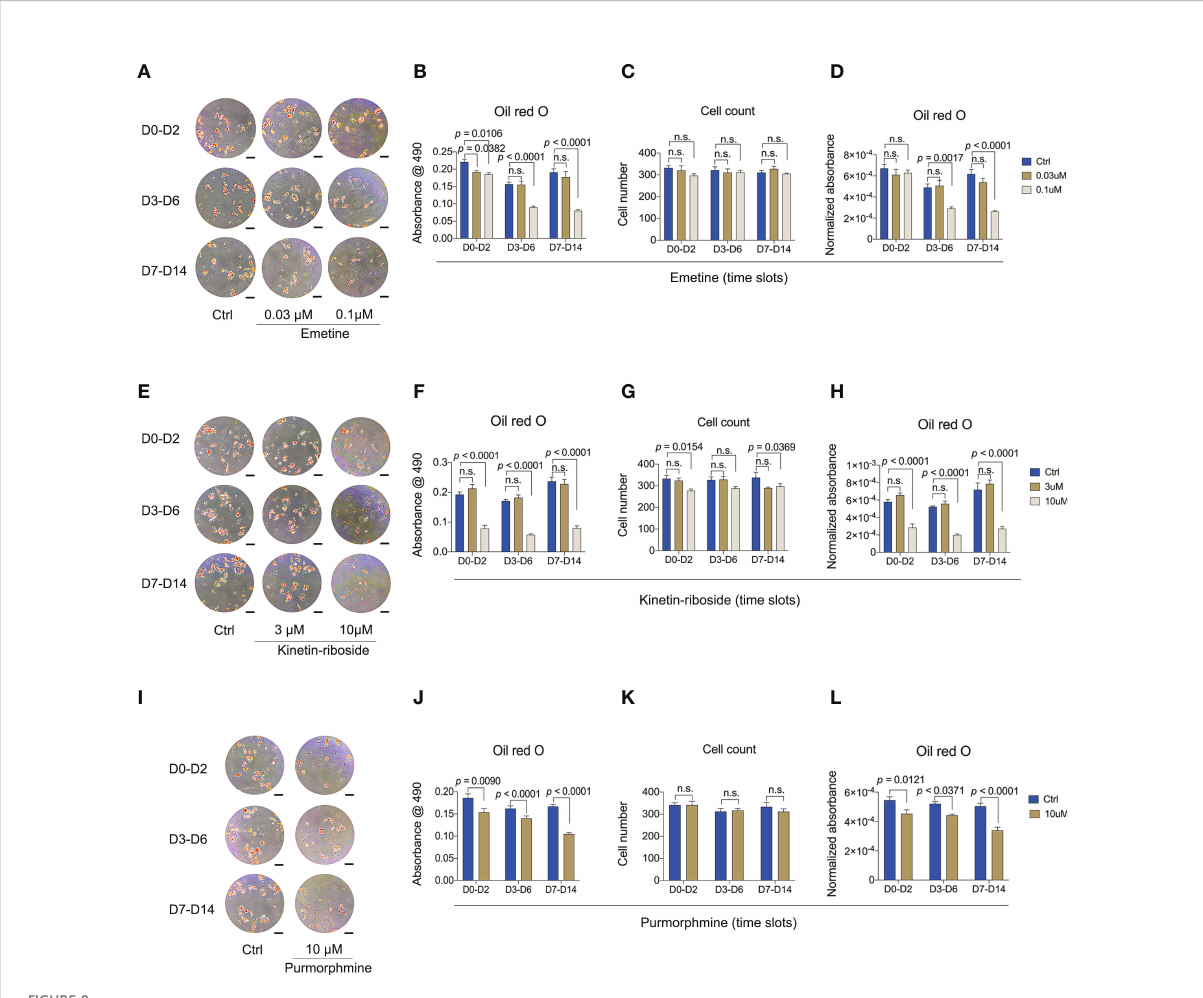
FIGURE 8 Anti-adipogenic effects of emetine, kinetin-riboside and purmorphamine are independent of treatment window. (A-D) Representative images (A) and quantitative data (B-D) of Oil Red O staining. Oil red O staining was performed after 14 days adipogenic differentiation from BMSCs following emetine treatment at indicated time slots. (E-H) Representative images (E) and quantitative data (F-H) of Oil Red O staining. Oil Red O staining was evaluated after 14 days adipogenic induction following treatment with kinetin-riboside at indicated time slots. (I-L) Representative images (I) and quantitative data (J-L) of Oil Red O staining. Cells were cultured in adipogenic induction medium following treatment with purmorphamine at indicated time slots. Normalized absorbance of Oil Red O (D, H, L) was adjusted by cell number (C, G, K) . Scale bars in A, E and I: 100 m